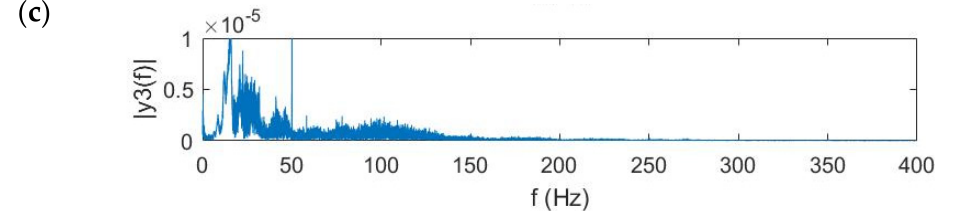
Figure 9. Frequency domain vibrational velocity on the ground measured at the burial depth of ( a ) 0.5 m, ( b ) 1 m, and ( c ) 1.5 m.